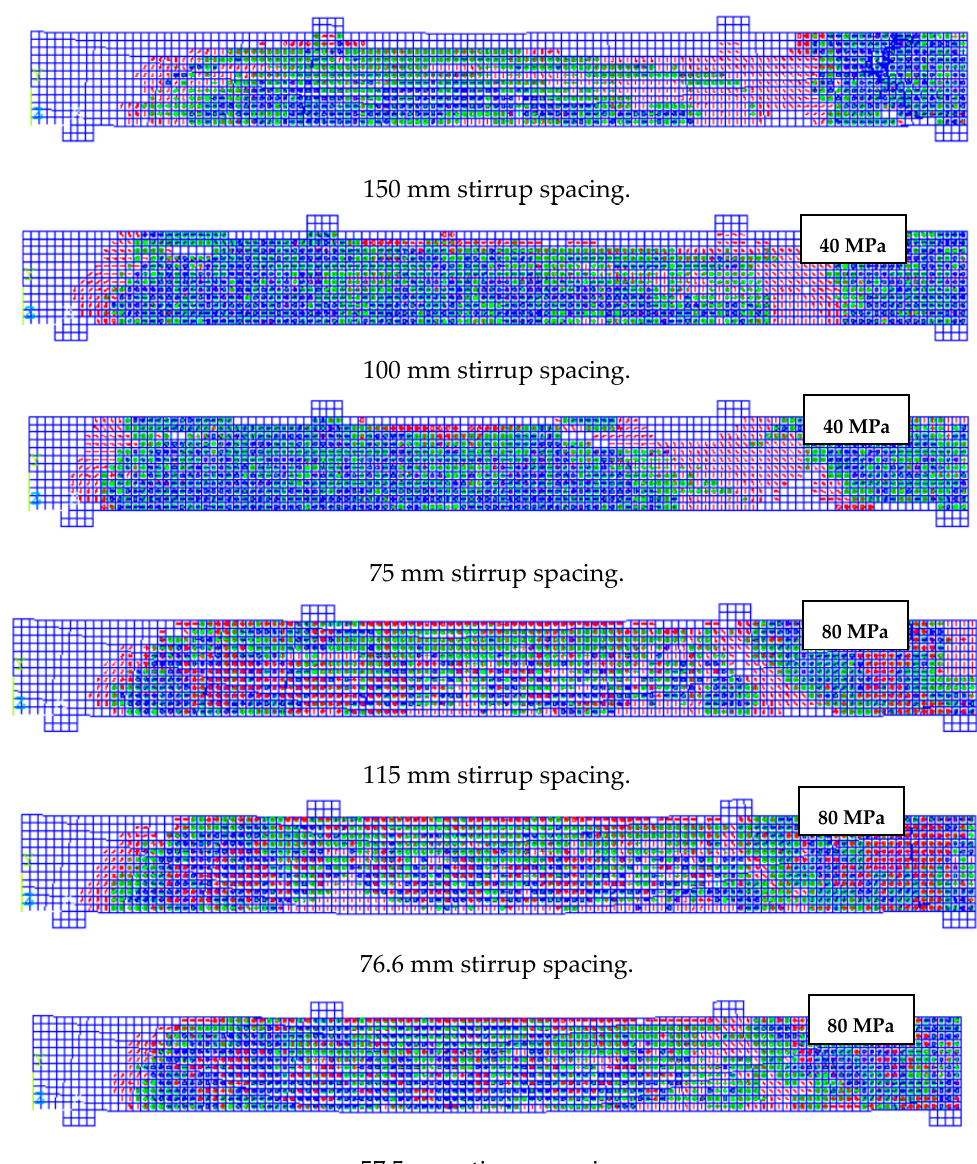
Figure 13. presents concrete crack ‐ crush plot for beams with variable stirrup spacing for normal and Figure 13. Presents concrete crack-crush plot for beams with variable stirrup spacing for normal and high strength concrete beam specimens. high strength concrete beam